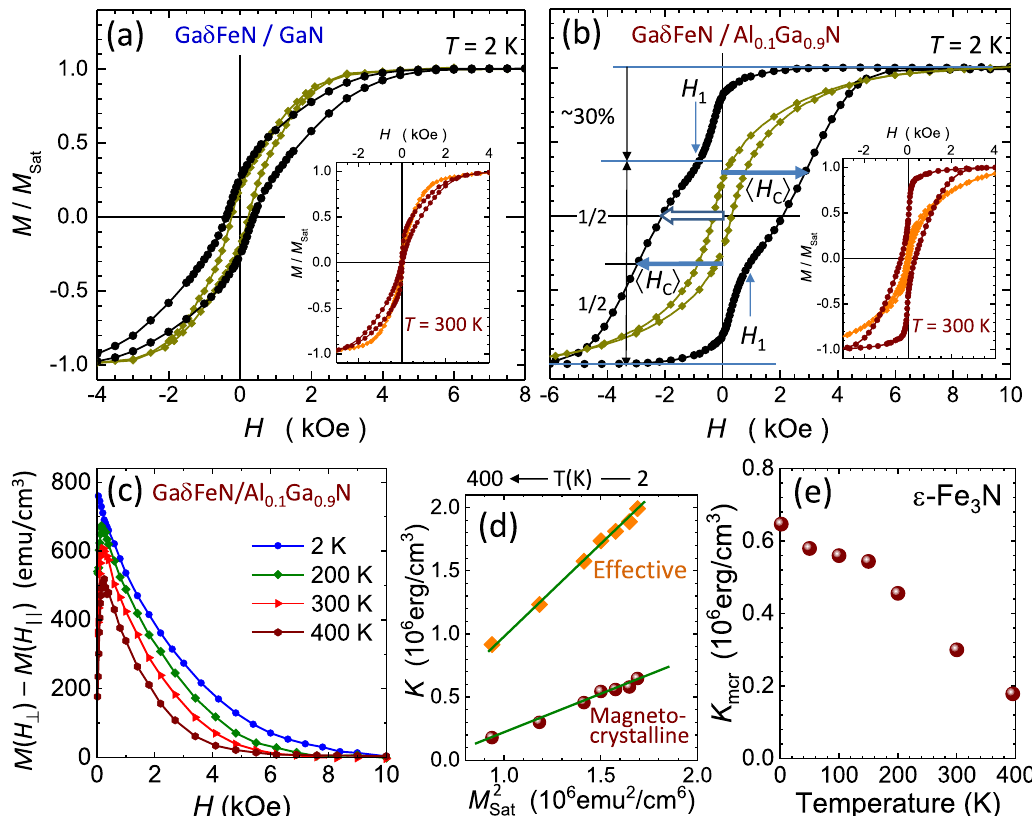
Figure 10. Normalized magnetization M / M sat acquired at 2K for the two magnetic field configurations H ⊥ (circles) and H (cid:107) (diamonds) for ( a ) the reference sample, and ( b ) Ga δ FeN/Al 0.1 Ga 0.9 N. The M / M sat at 300K as a function of the magnetic field is depicted in the insets. The vertical arrows mark an inflection point H 1 on M ( H ⊥ ) separating two different contributions to M during its reversal. The empty arrow marks the coercive field of the whole ensemble, whereas the lengths of the two full arrows indicate the average coercive field (cid:104) H C (cid:105) of the prolate part of the distribution. ( c ) Magnetic anisotropy M ( H ⊥ ) − M ( H (cid:107) ) obtained for the Ga δ FeN/Al 0.1 Ga 0.9 N sample acquired at selected temperatures. ( d ) Magnitudes of K eff established from the area under the curves in ( c ) plotted as the function of M 2 (diamonds) and of K mcr of ε -Fe 3 N (bullets). Solid lines mark the proportionality of Sat both K eff and K mcr to M 2 . ( e ) Temperature dependence of K mcr of ε -Fe 3 Sat